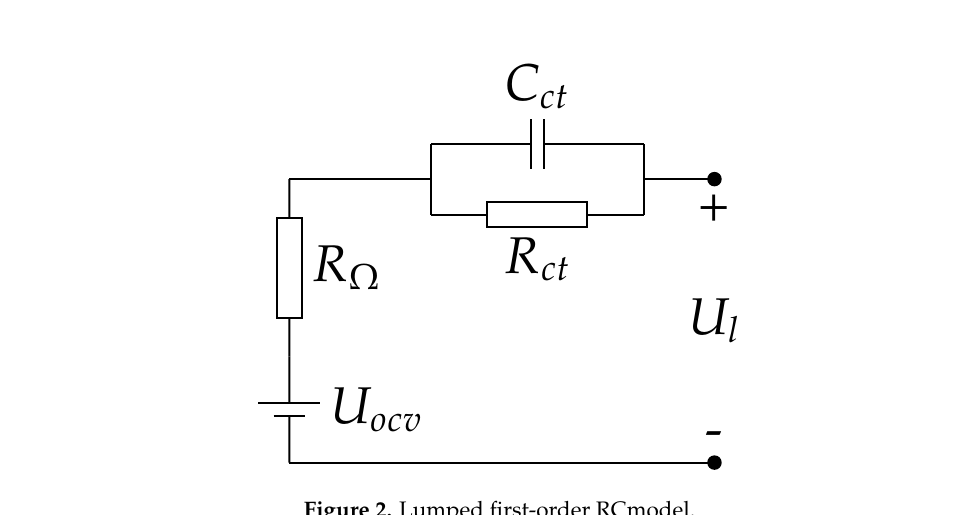
Figure 2. Lumped first-order RCmodel.